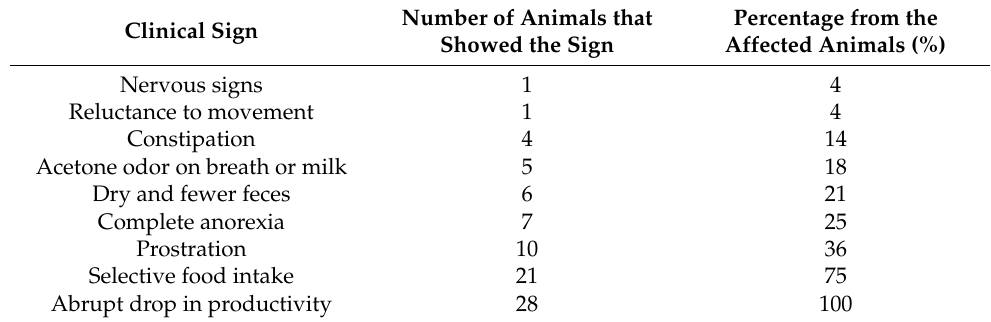
Table 4. Relative frequency of the different clinical signs that can be manifested by a cow with ketosis (adapted from